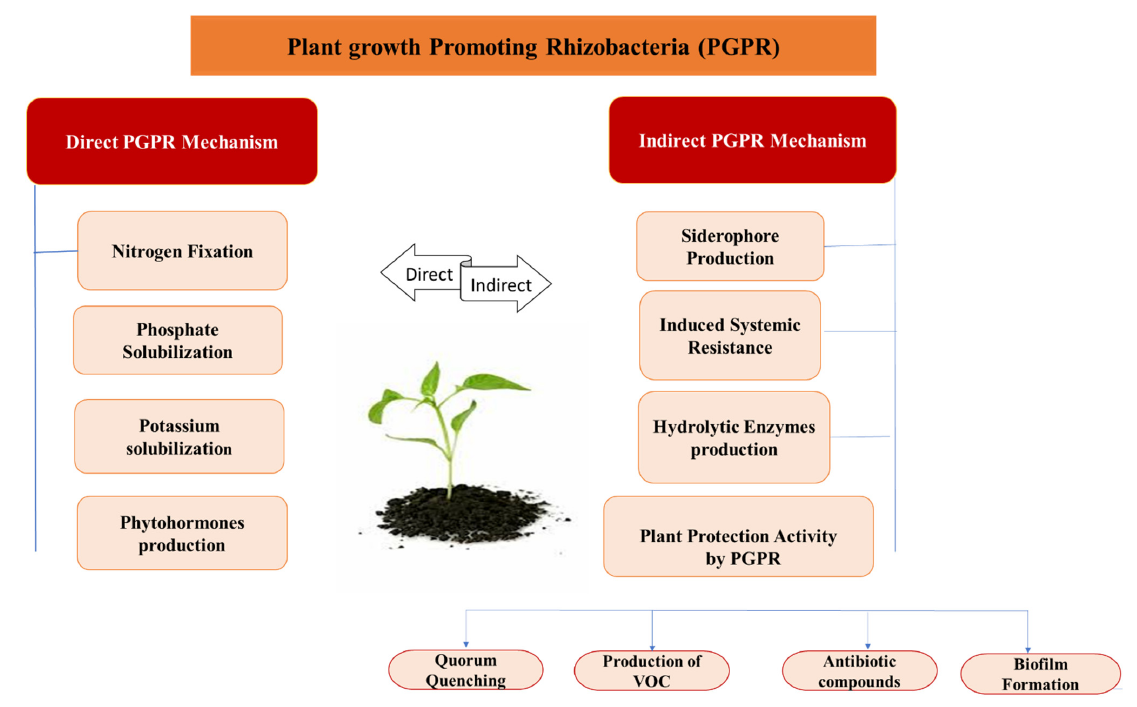
Figure 4. Direct and indirect mechanisms of plant growth promoting activities of